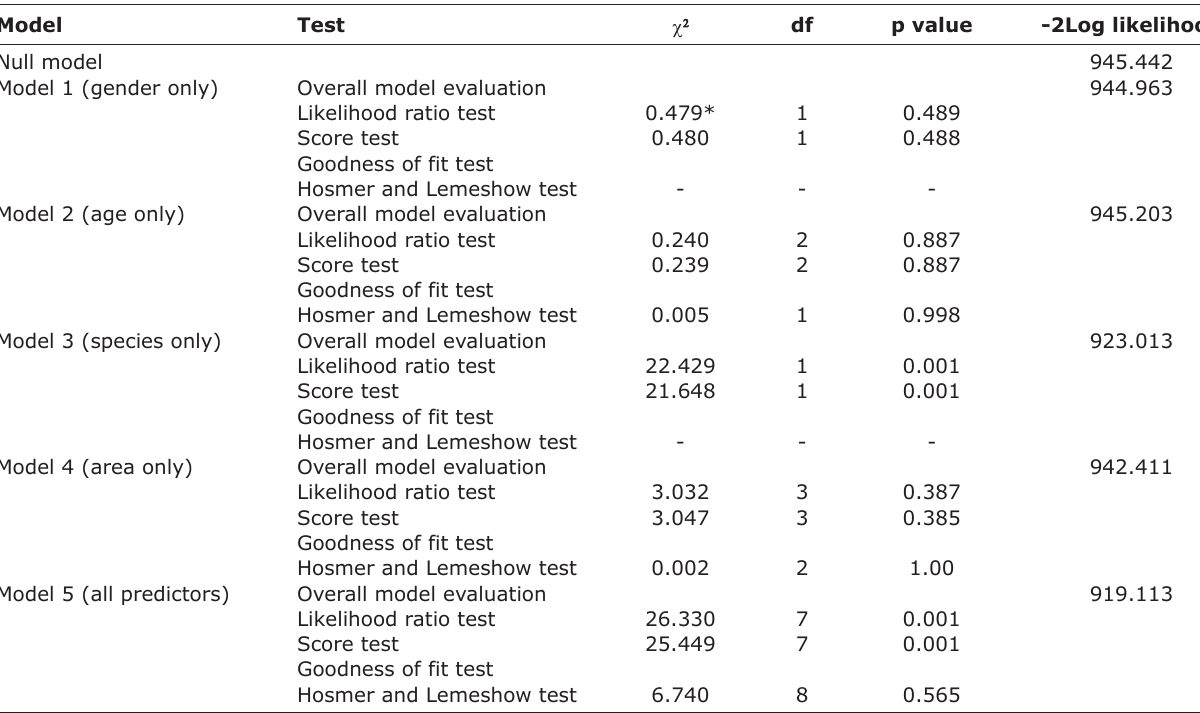
Table-6: Overall models evaluation and goodness of fit statistics. Model